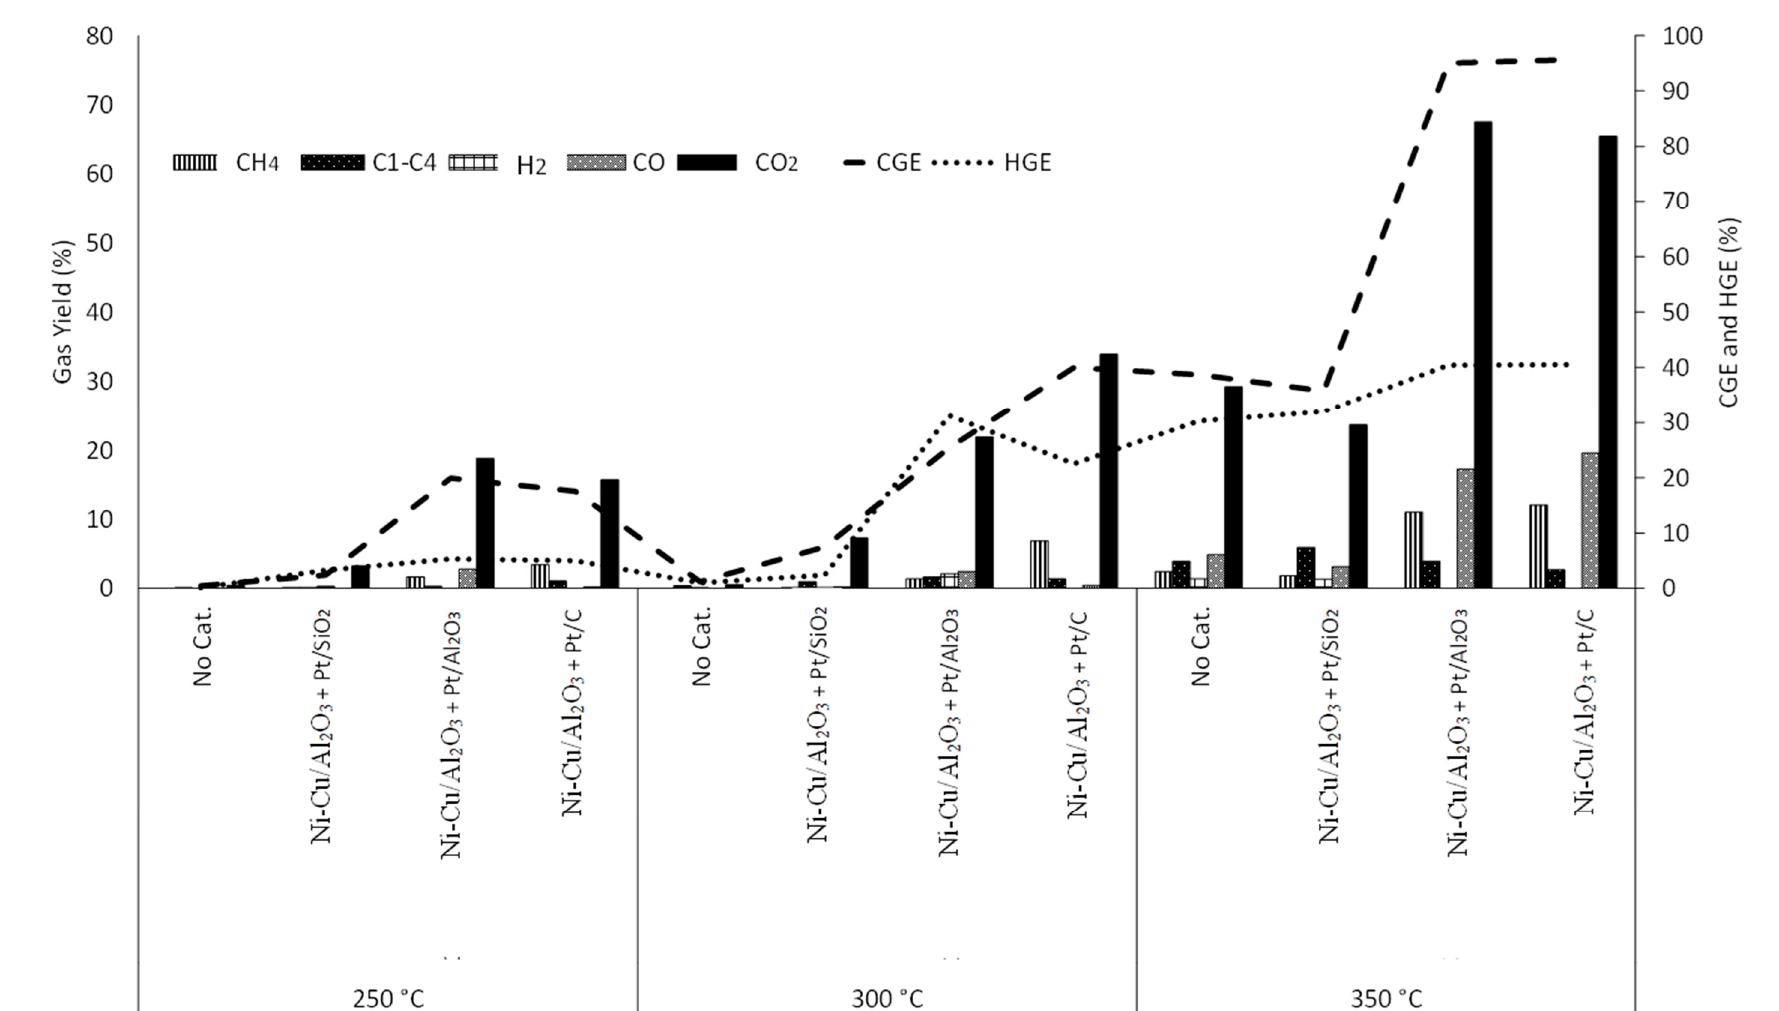
Figure 6. Effect of temperature on reforming of glycerol using 50/50 wt% combination of Ni ‐ Cu/Al 2 O 3 and the Pt ‐ based catalysts.